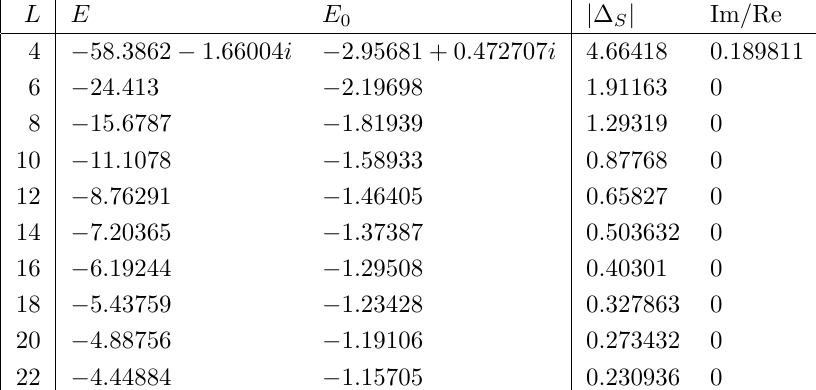
Table 2 . E (2.15), E 0 (2.17), | ∆ S | (2.21), and Im / Re (2.22) for the “ghost brane” solution Φ G